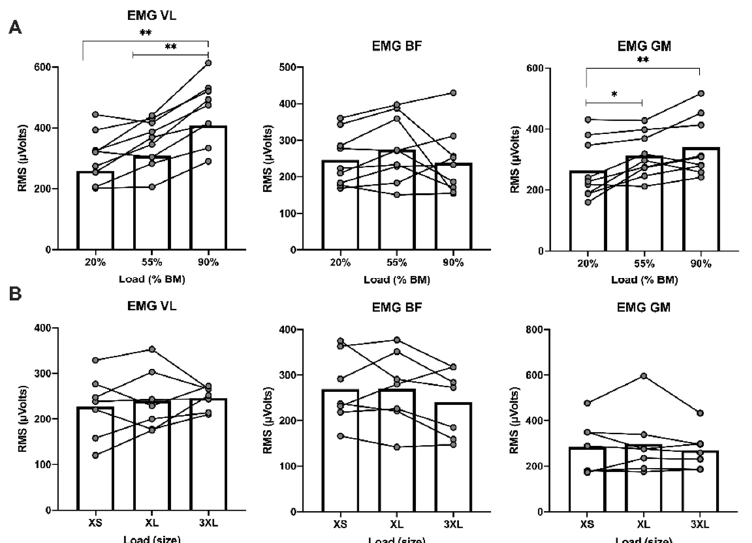
Figure 2. ( A ) Comparison of muscle activation of VL, BF and GM in sled-push under different load conditions. ( B ) Comparison of muscle activation of VL, BF and GM in resisted-parachute sprinting